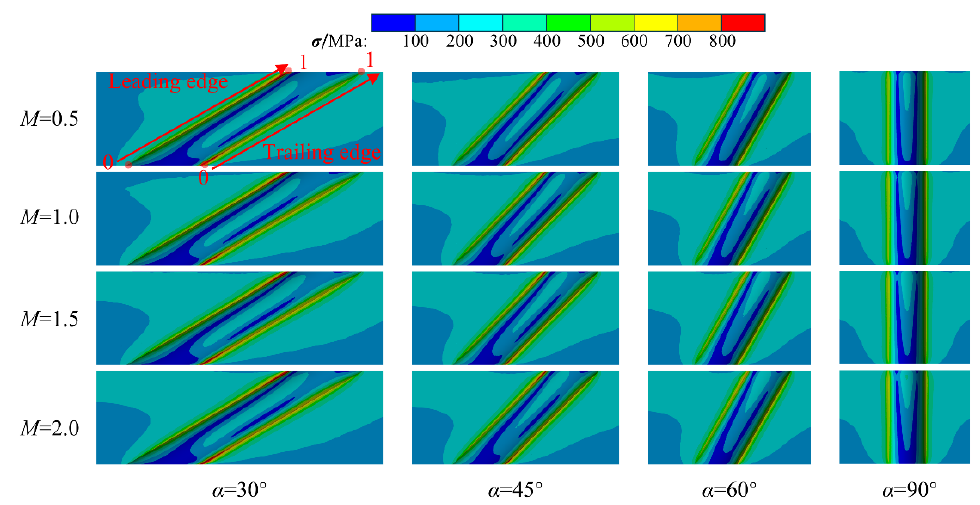
Figure 23. Contours of thermomechanical stress at Y = 0 plane near the research film hole.